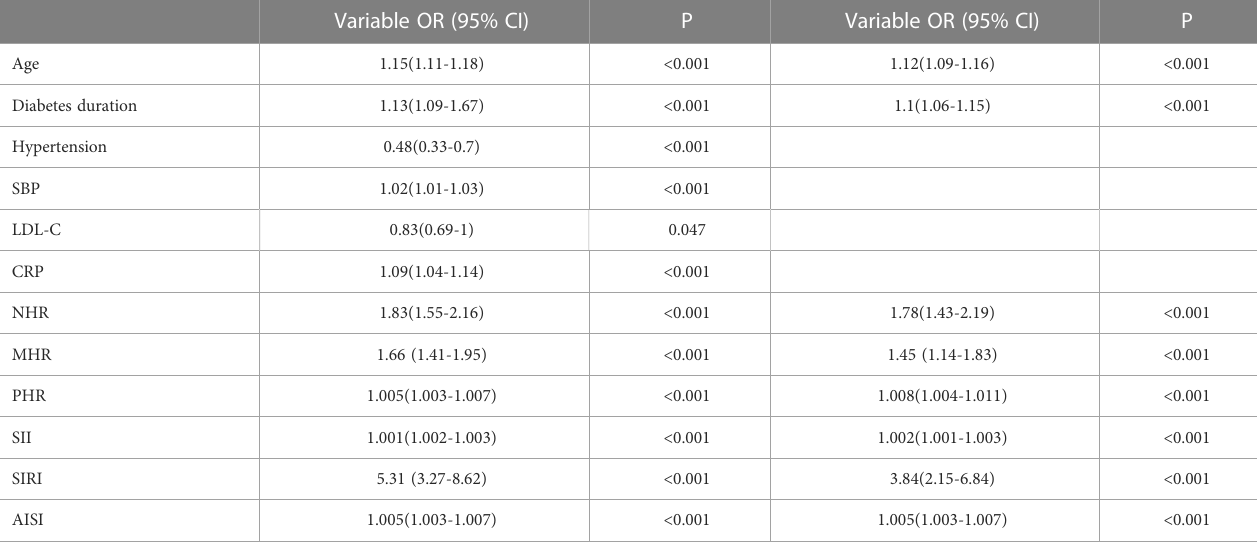
TABLE 5 Univariate and binary logistic regression analysis results.